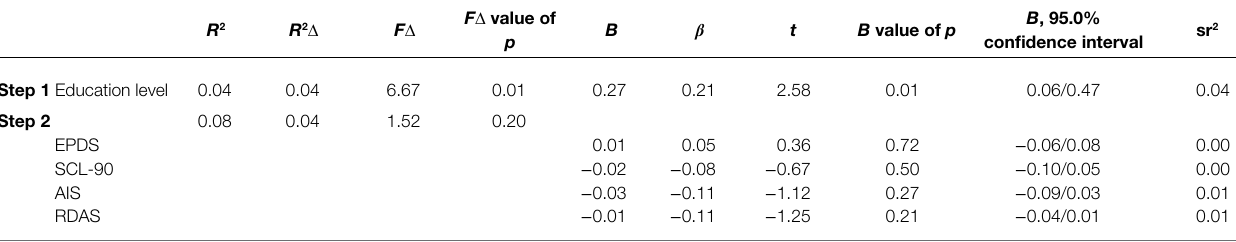
TABLE 4 | Associations between continuous symptoms and executive functioning. R 2